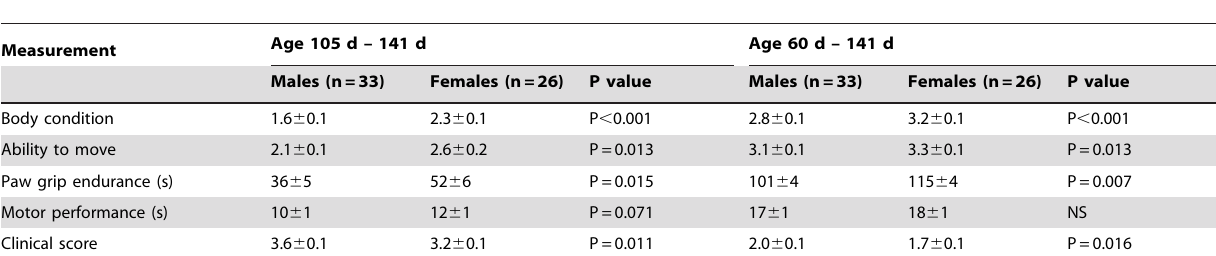
Table 4. Body condition, functional outcomes and clinical score between the sexes in G93A mice.